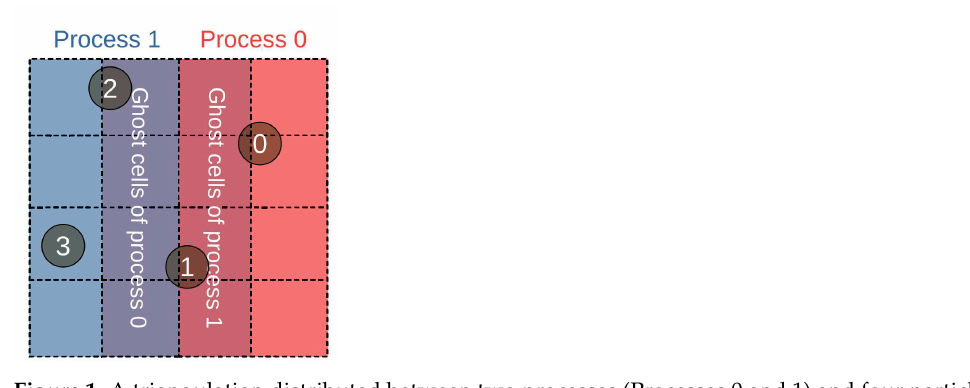
Figure 1. A triangulation distributed between two processes (Processes 0 and 1) and four particles. The ghost cells are highlighted for each process. Particles 0 and 3 are local particles for processes 0 and 1, respectively, while particle 1 is a ghost particle of process 1 and particle 2 is a ghost particle of process